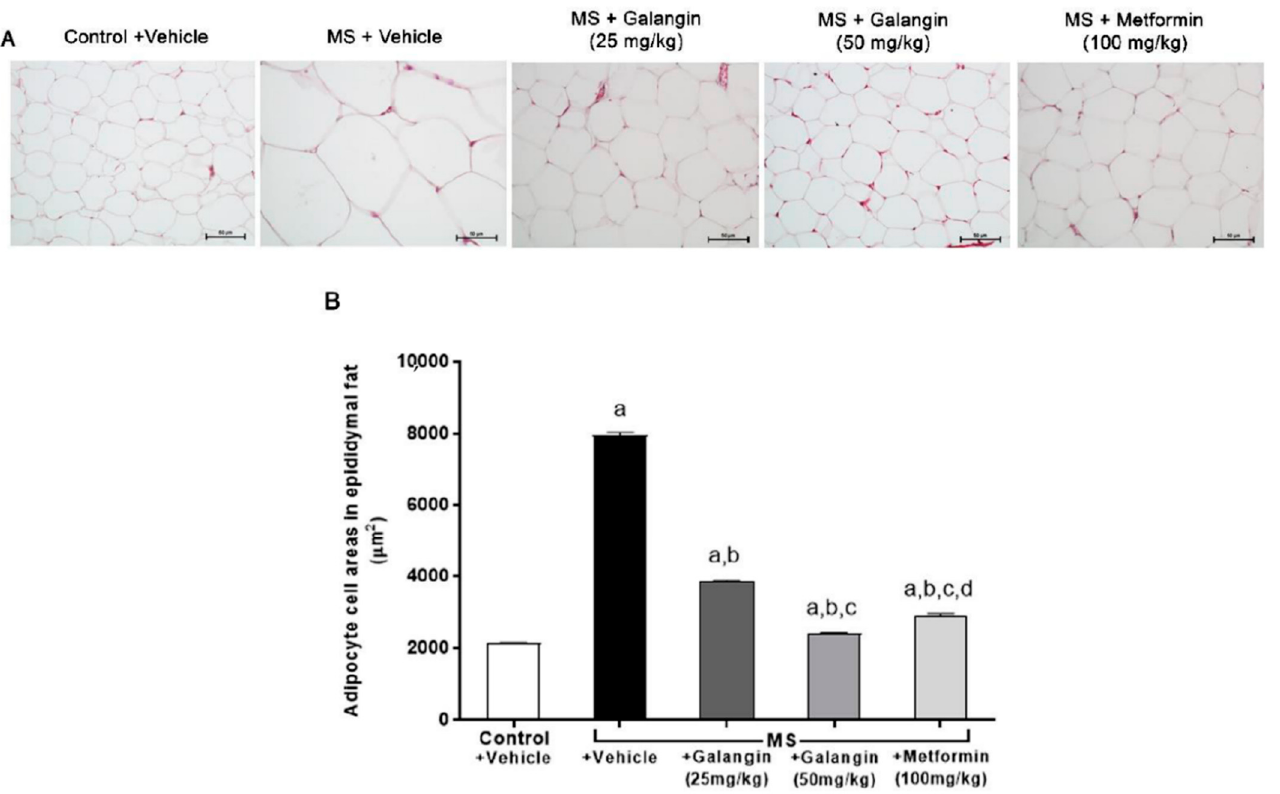
Figure 2. Morphology of epididymal fat pads. ( A ) Representative photographs of epididymal fat sections stained with hematoxylin and eosin (H&E) (magnification × 200, scale bar = 50 µ m). ( B ) Effects of galangin and metformin treatments on adipocyte cell areas. Data are presented as the mean ± S.E.M. ( n = 8). a p < 0.05 vs. the control group, b p < 0.05 vs. the MS group, c p < 0.05 vs. the MS + galangin (25 mg/kg) group, and d p < 0.05 vs. the MS + galangin (50 mg/kg) group.